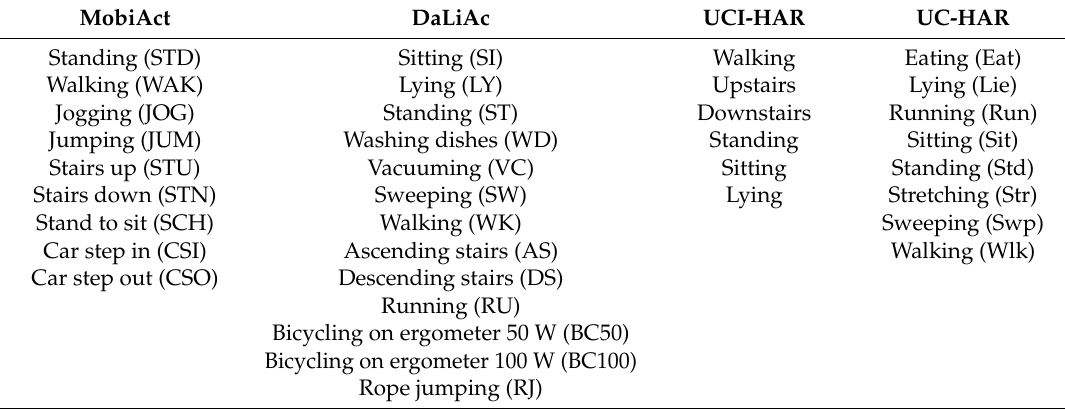
Table 2. Activity list for all the datasets and their